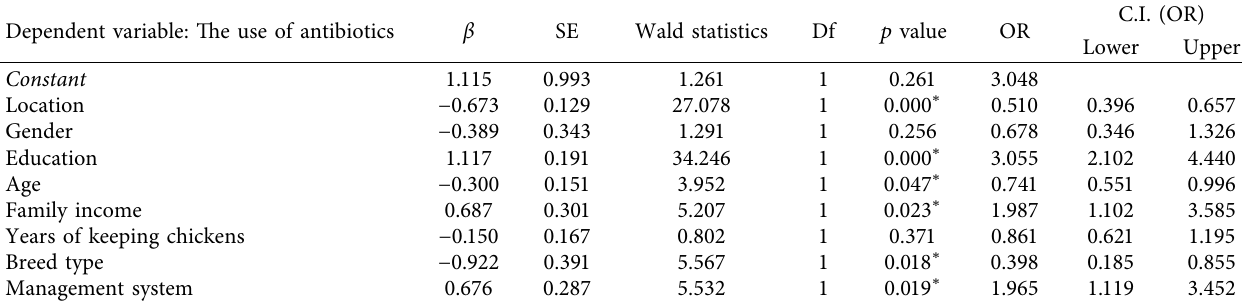
Table 6: Distribution of independent variables predicting antimicrobial usage in smallholder poultry production. Dependent variable: The use of antibiotics β SE Wald statistics Df p value OR